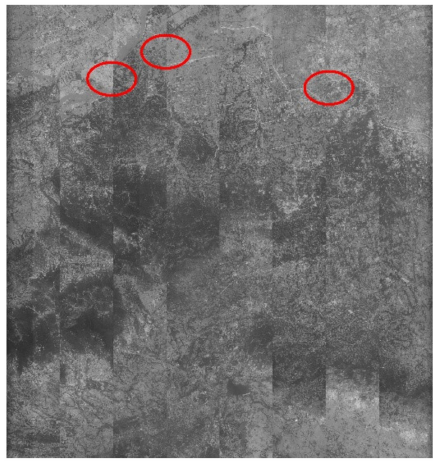
Figure 11. TH-1 HR camera image.